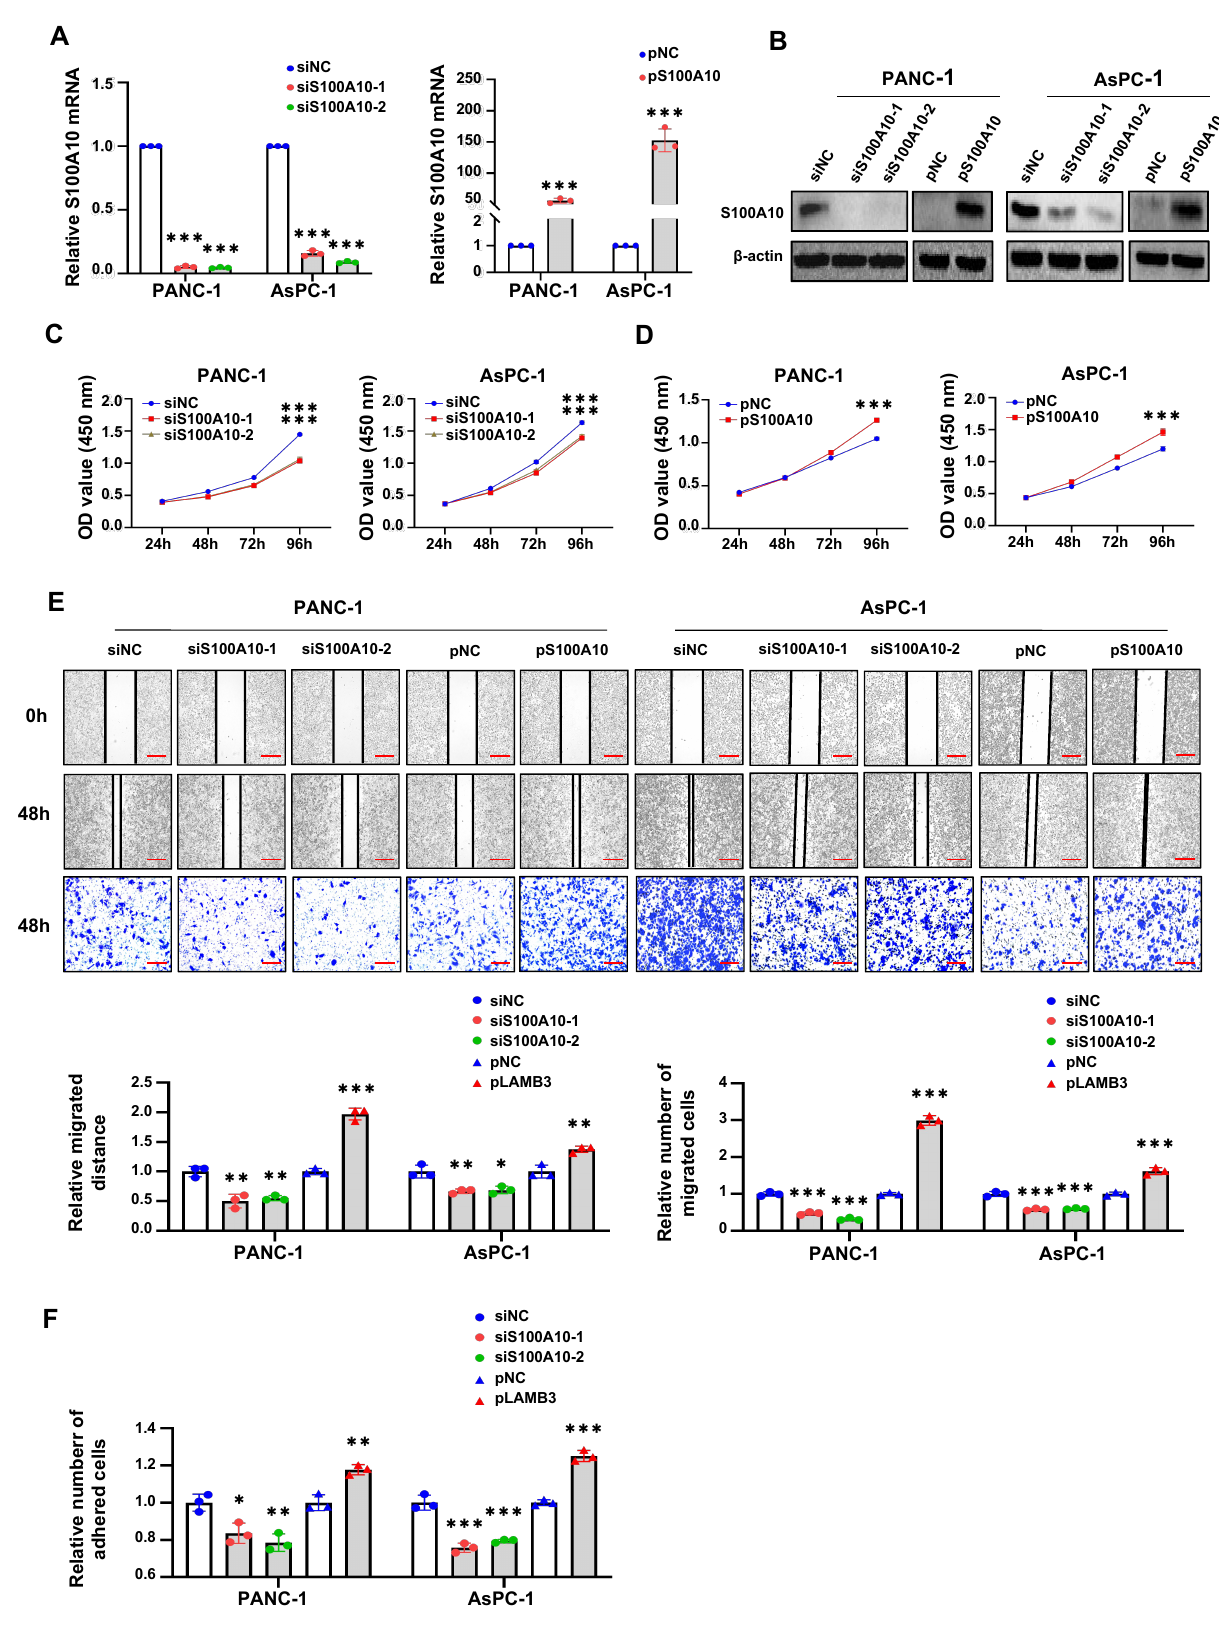
Figure 2. S100A10 promotes PDAC cells proliferation, migration and adhesion in vitro. ( A , B ) RT- qPCR and Western blotting were used to measure the expression of S100A10 in PANC-1 and